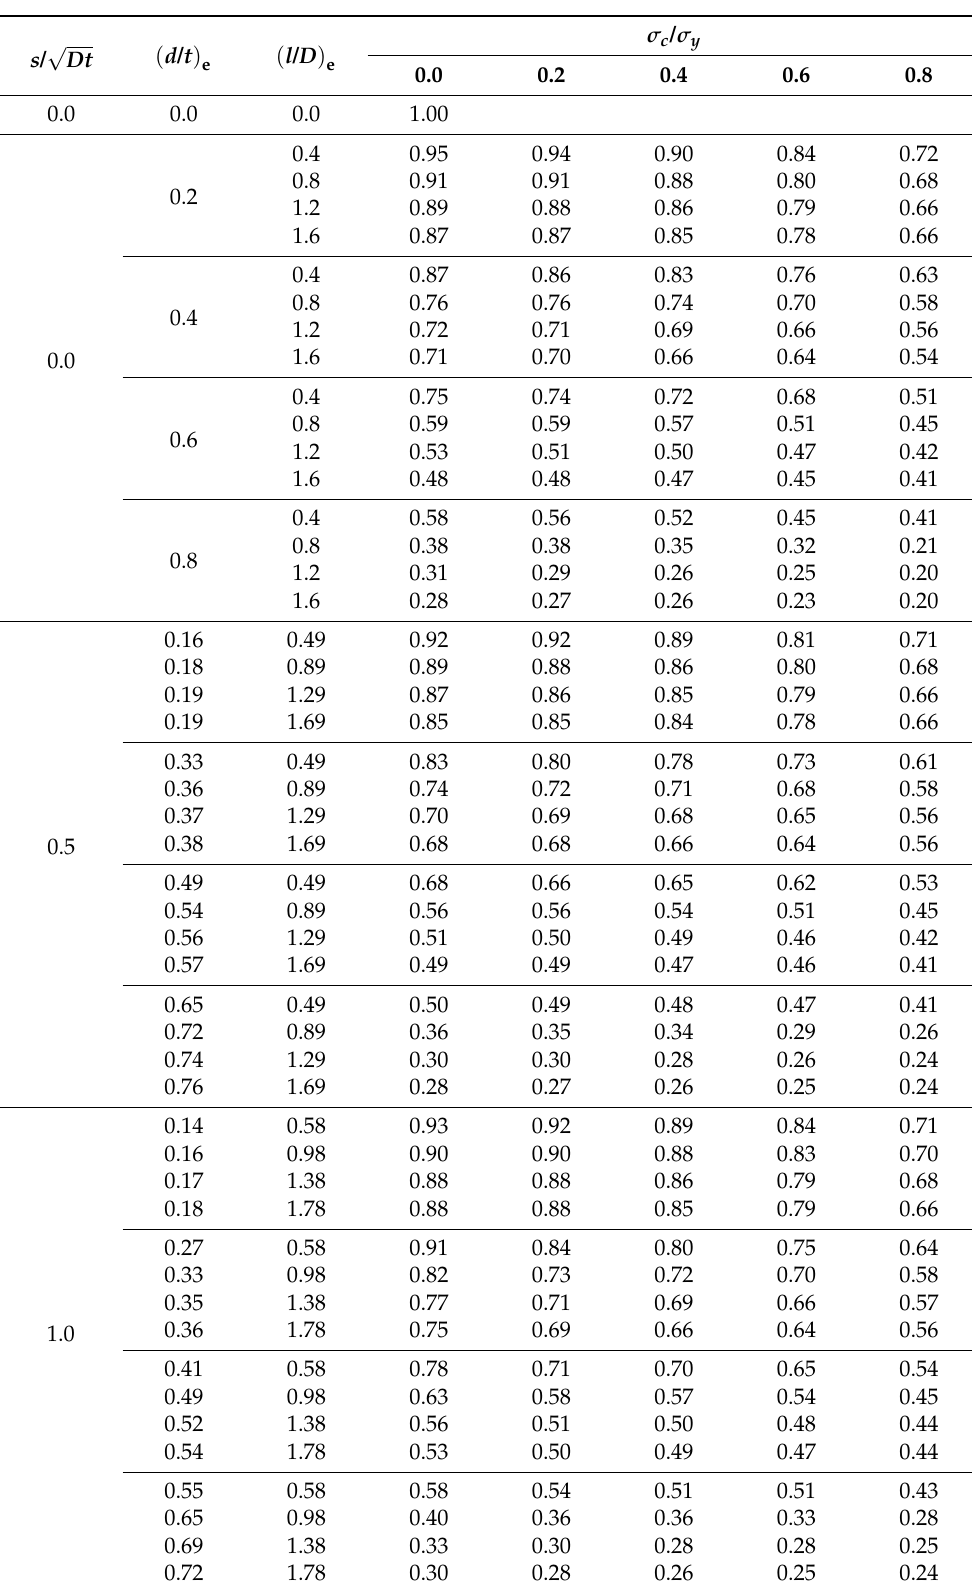
Table 3. ANN training